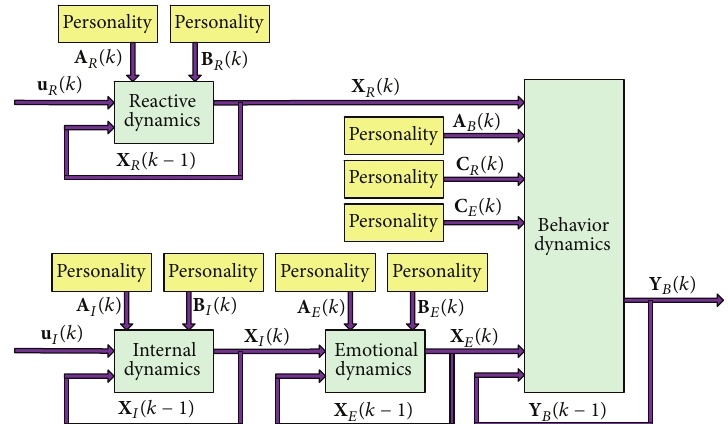
Figure 1: The personality-based emotional decision model, which consists of four dynamics and nine personality matrices.